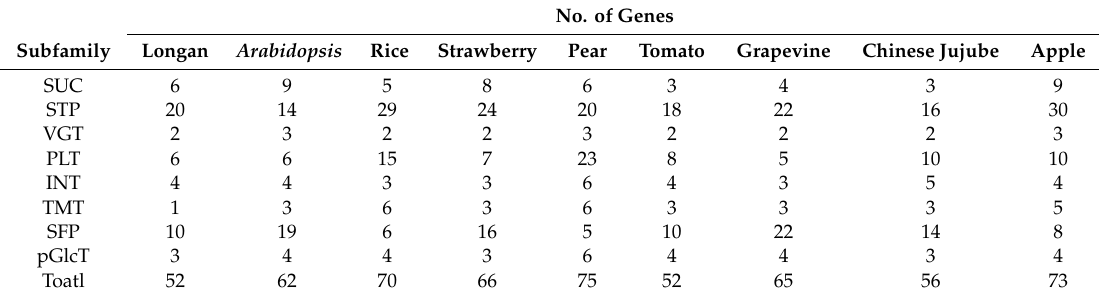
Figure 2. Phylogenetic analysis of DlST proteins. The eight classes are marked by different colors. Table 2. Comparative analysis of sugar transporter (ST) gene families in Arabidopsis , rice, strawberry, pear, tomato, grapevine, Chinese jujube and apple.